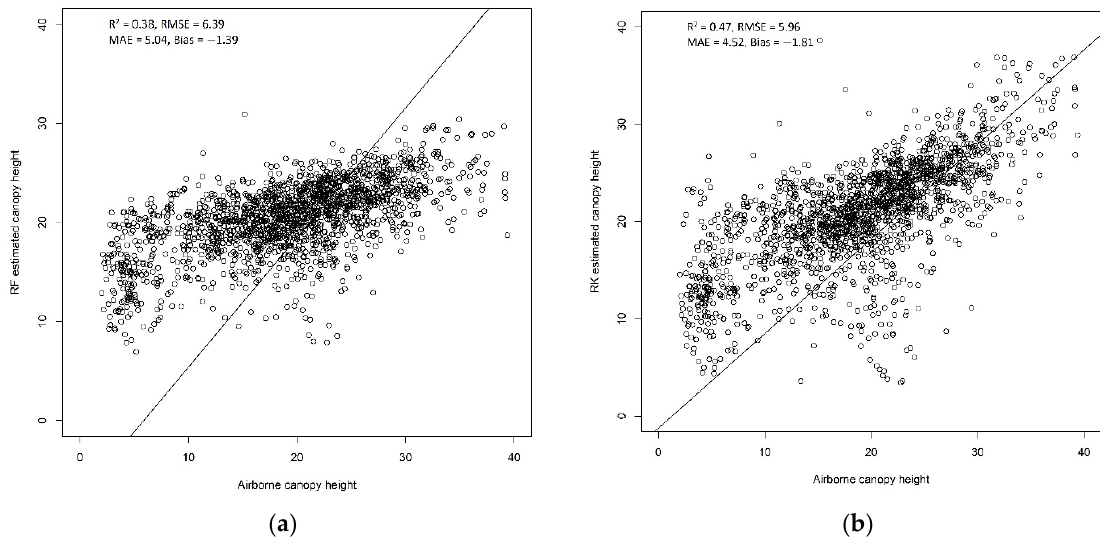
( b ) Figure 5. Histogram of observed and estimated canopy height at 30 m spatial resolution from the independent validation for ( a ) random forest and ( b ) regression kriging 3.2. Comparison of Canopy Height Estimated by RF and RK with Airborne Lidar Canopy Height Data Pixels coinciding with the ATL08 point data were used for comparing the canopy height estimated by RF and RK with airborne lidar canopy height data. Compared with